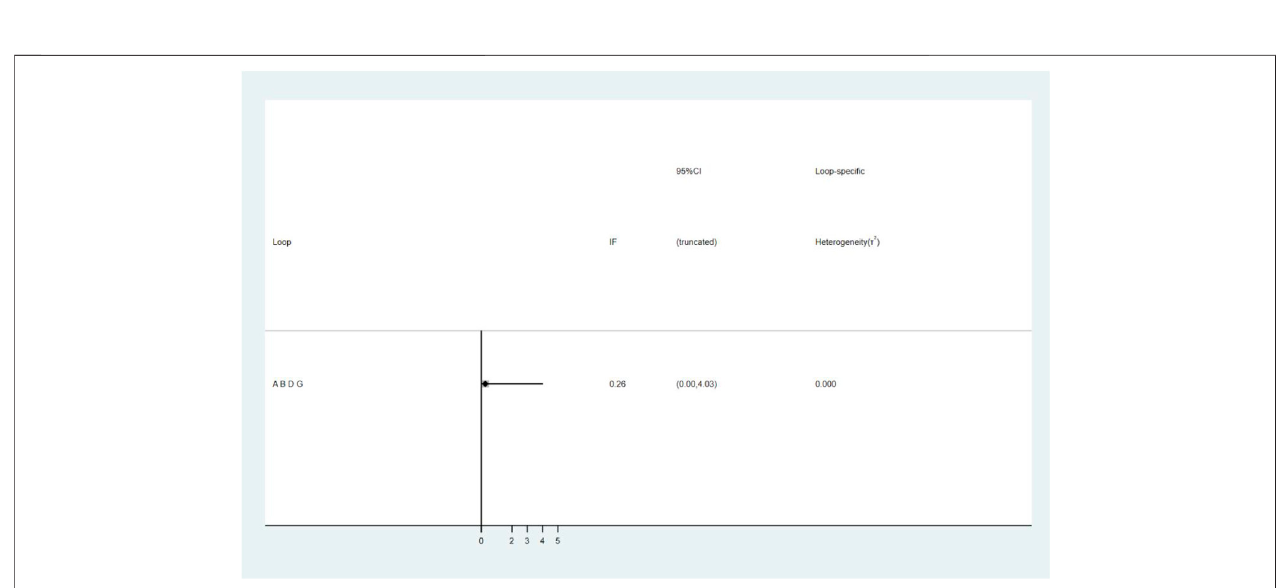
FIGURE 5 | The result of loop inconsistency test. A: conventional treatment; B: conventional treatment + trimetazidine + Astragalus injection; D: conventional treatment + trimetazidine; G: conventional treatment + trimetazidine + Shenmai injection.